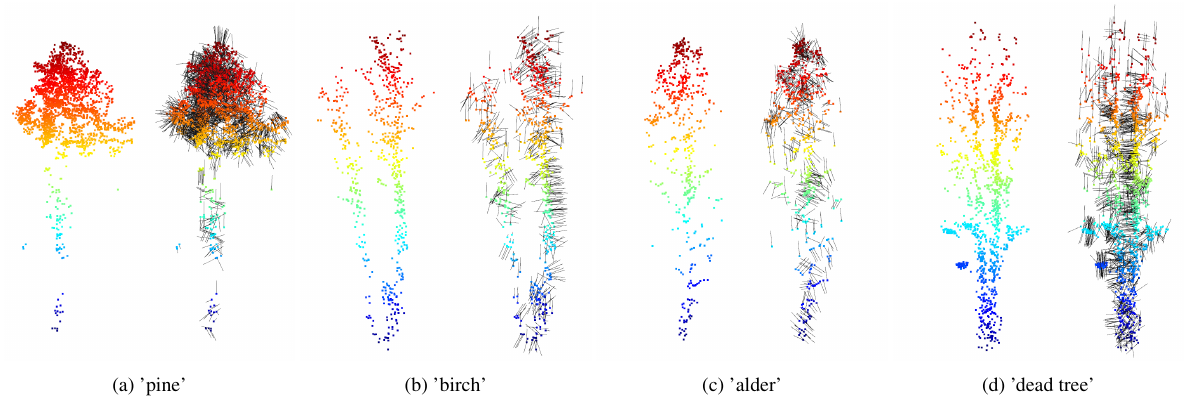
Figure 3. Samples of 3D point clouds per tree class; for each class, the samples on the right show surface normals.